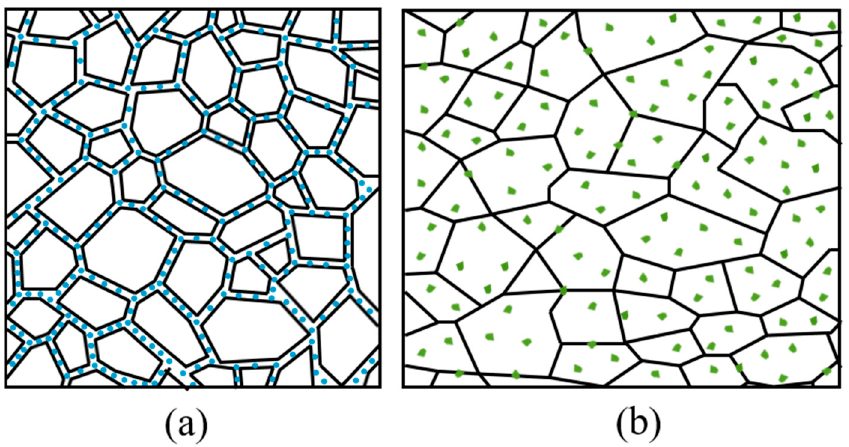
Figure 7. Schematic diagram of particle reinforced TiC matrix ( a ) pinning effect, ( b ) refinement ef- fect.